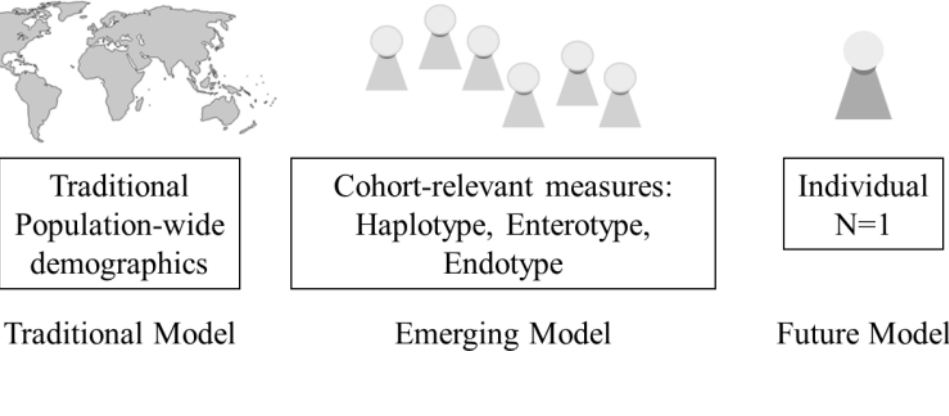
Figure 2. Classification models in personalized